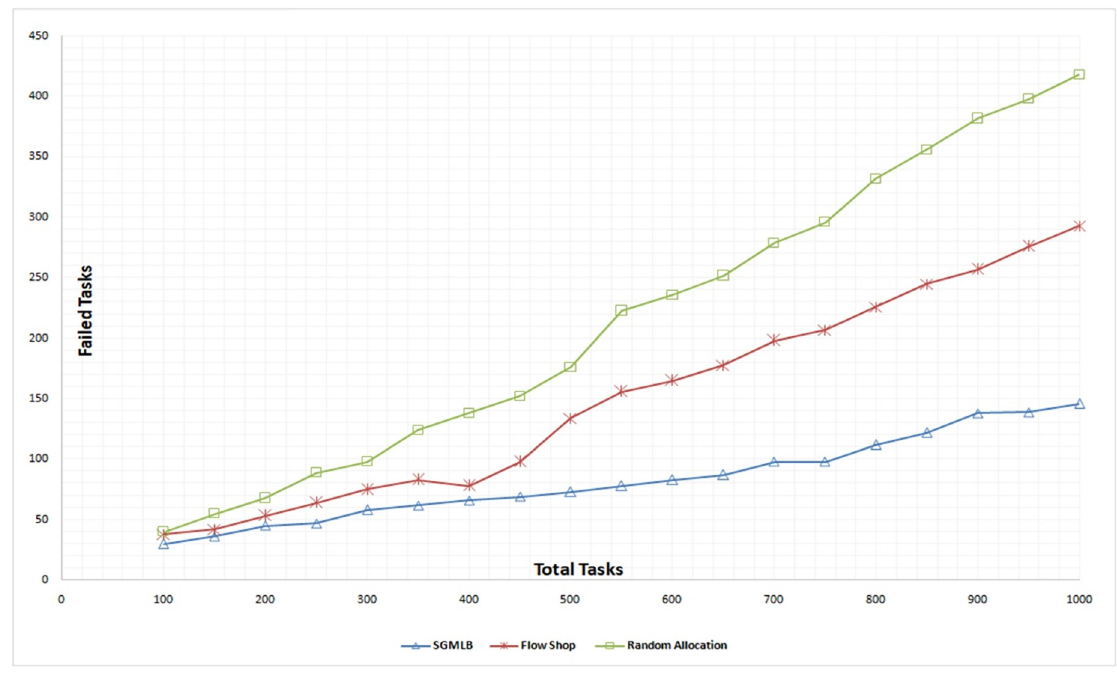
Fig 4. Failed number of tasks